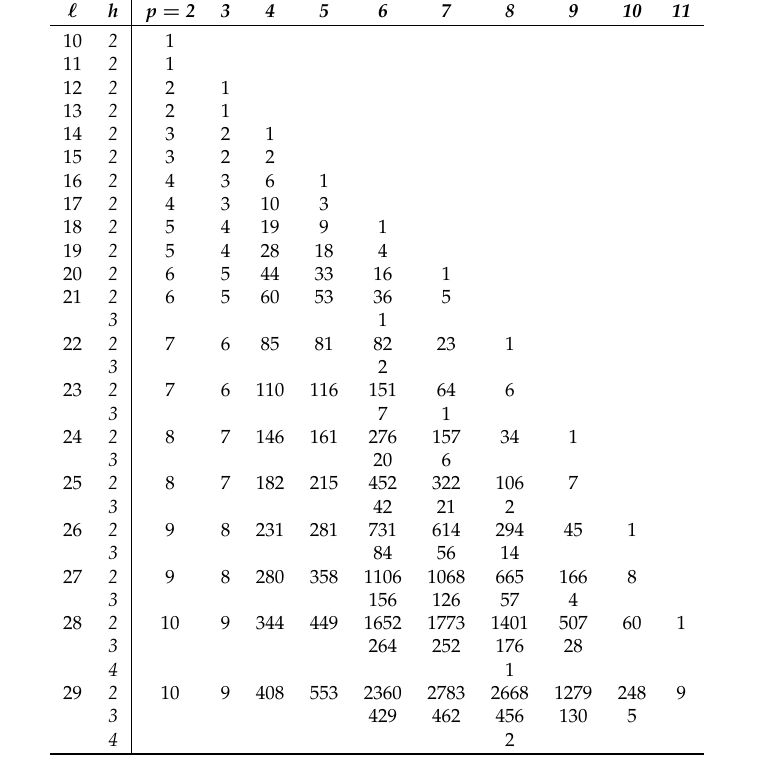
Table 2. Number of circular RNA structures of length (cid:96) , exhibiting h hairpins and p base